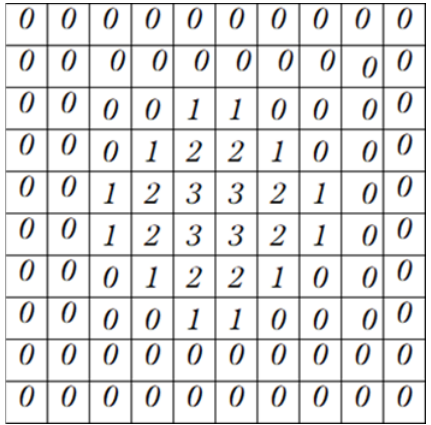
Figure 3. Signal Strength Map.